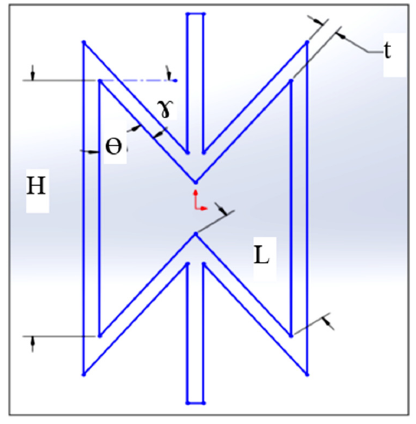
Figure 1. Configuration of the re-entrant unit cell. Table 1. Re-entrant unit cell geometrical parameters and their corresponding ranges. Parameter Min. Value Max. Value